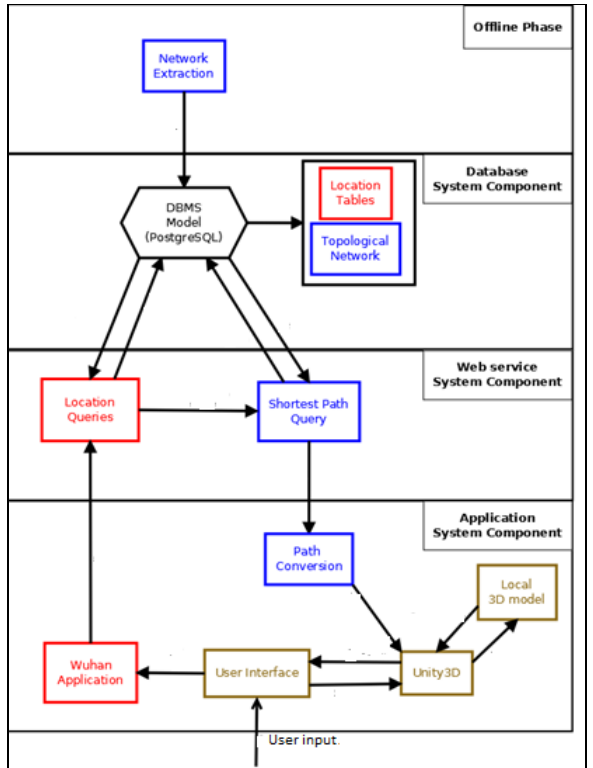
Figure 5. Conceptual model of the system